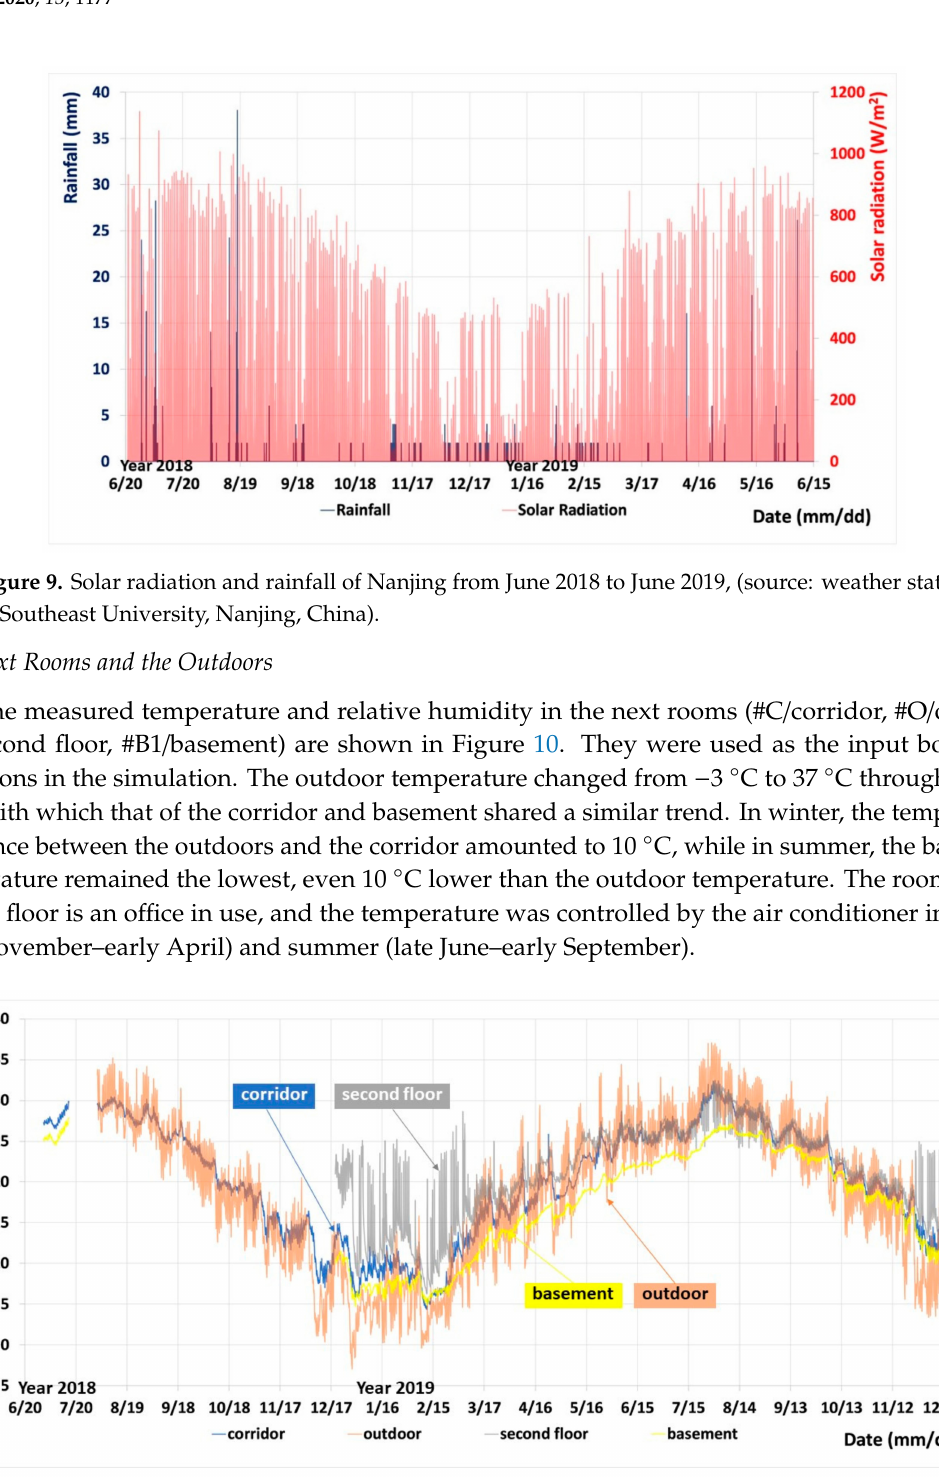
Figure 10. The measured temperature of the next rooms and the